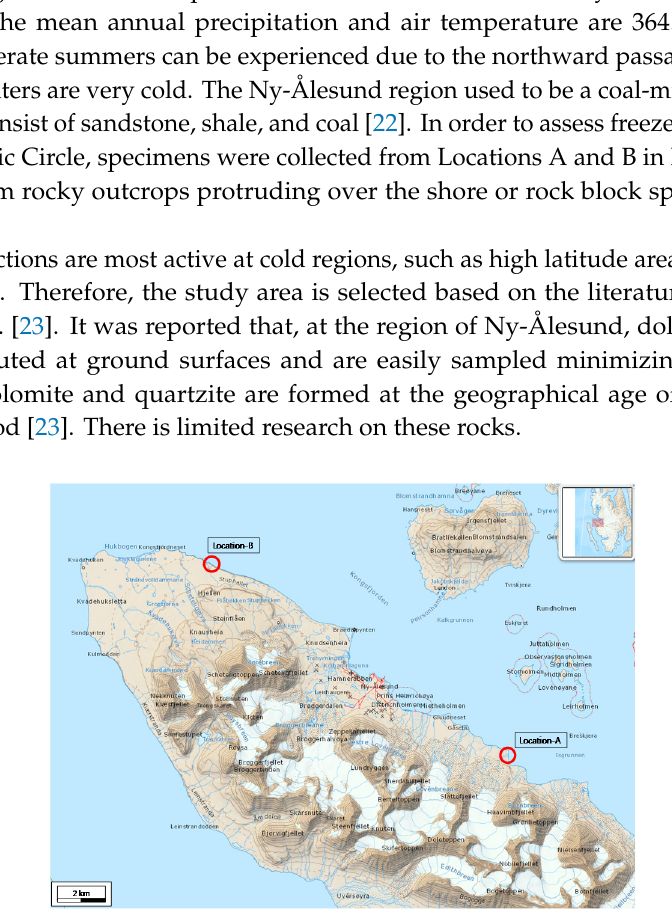
Figure 1. Location of the study area and topographic map in Ny-Ålesund (map reproduced from the original source [24] with courtesy of the Norwegian Polar Institute)